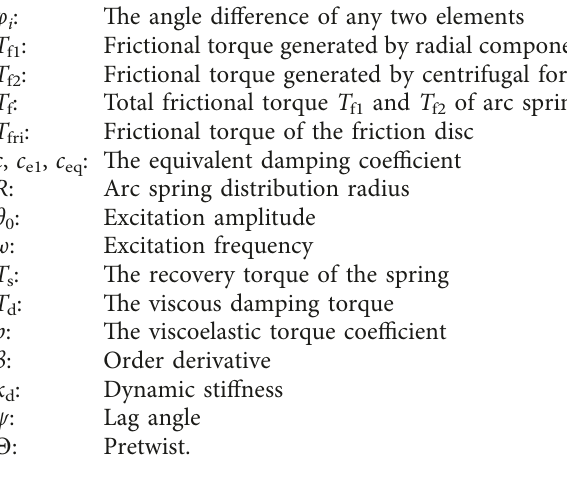
d . (b) Lag angle ψ